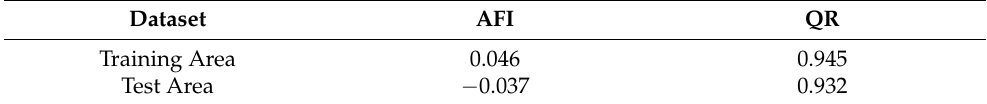
Table 3. Segmentation quality metrics for the training and test area